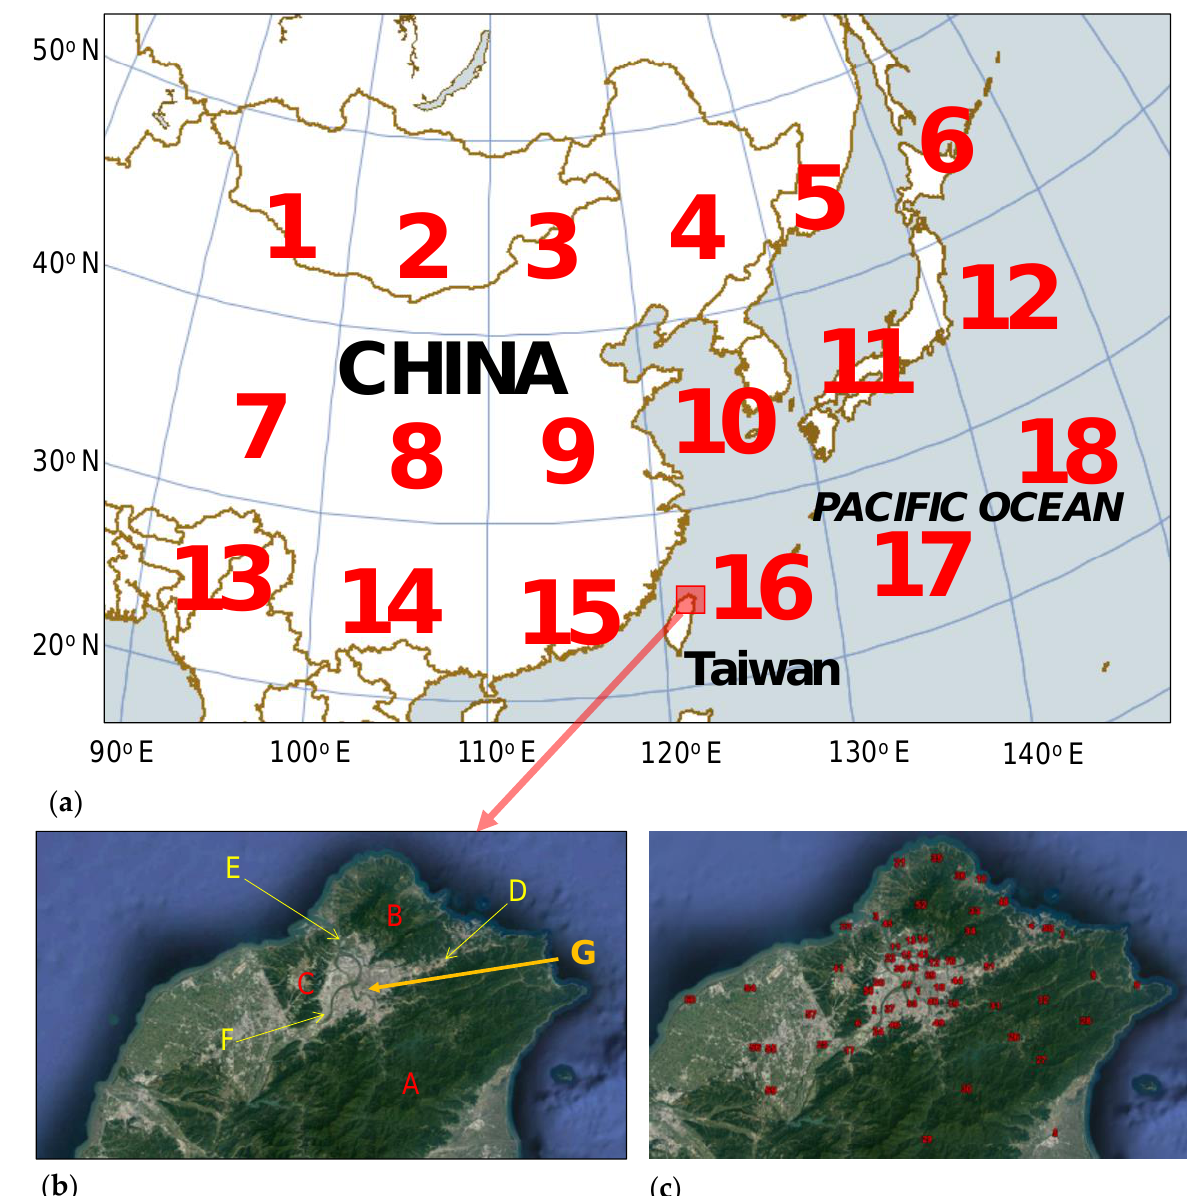
Figure 1. Geographical information of Taiwan. ( a ) Location of the Taiwan island and Taipei metropolis. ( b ) Topographical features of the Taipei metropolis. A: Snowy Mountains; B: Tatun volcano group; C: Linkou tableland; D: Xindian River Basin; E: Tamsui River Basin; F: Tahan River Basin; G: Taipei Basin. ( c ) Locations of the monitoring sites of the Environmental Protection Administration and Central Weather Bureau. Numbers correspond to number signs (No.) of sites in Table 1. Satellite figures were retrieved from Google Earth, available at: https://earth.google.com/web/@25.07001375,121.56191713,4.3012896a,106580.52557716d,35y,0.294h,0t,0r?utm_source=earth7&utm_campaign=vine&hl=zh-TW (accessed on 4 June 2022).